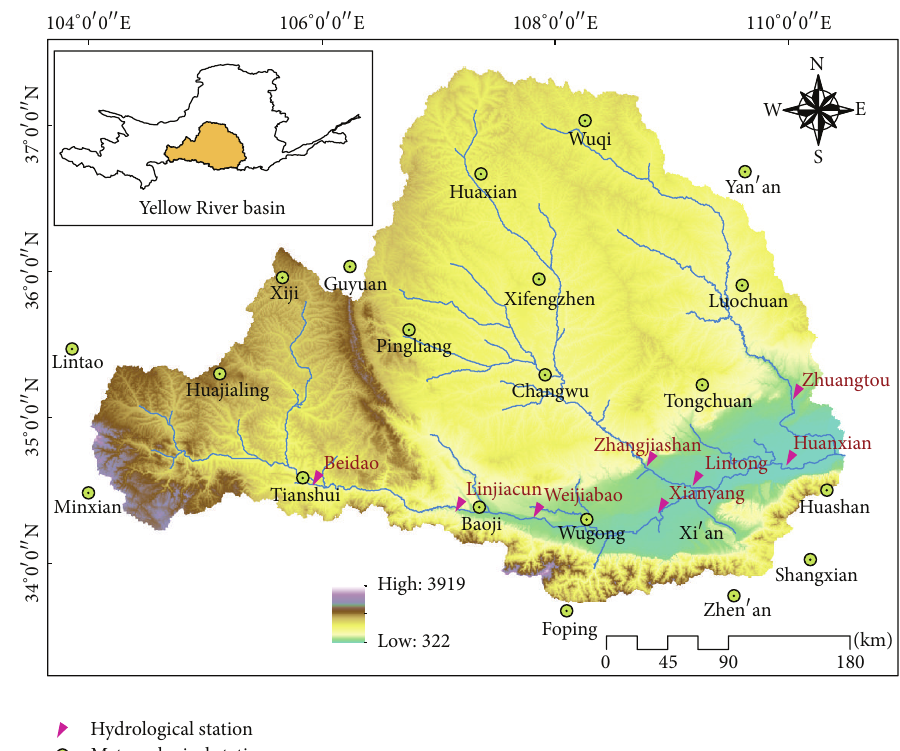
Figure 1: Map of the River Wei